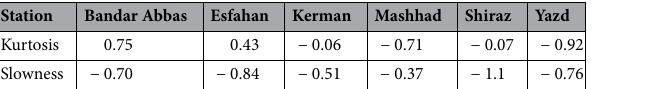
Table 4. Statistical analysis (Kurtosis, Slowness) on